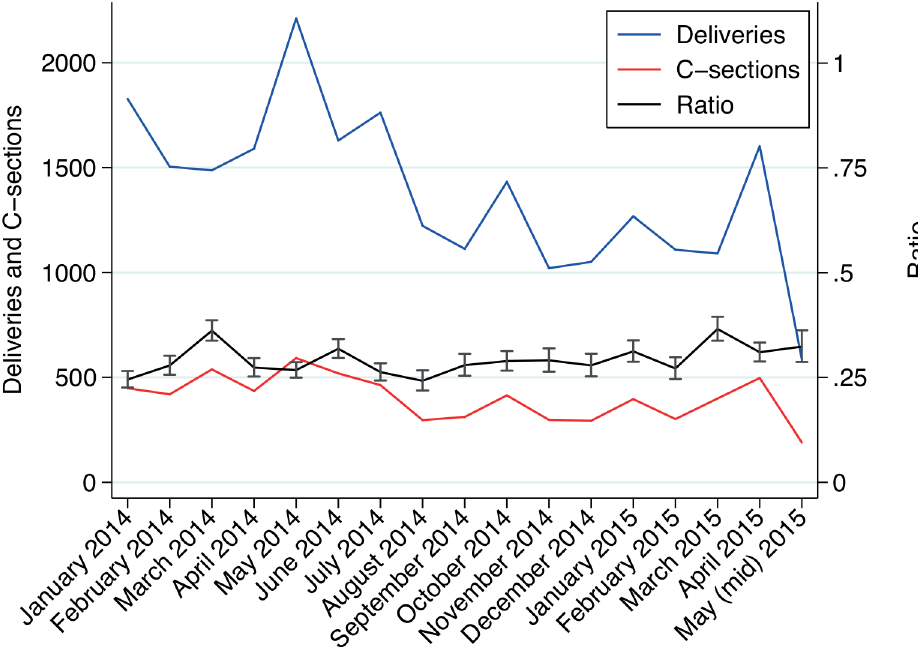
Fig 3. Monthly number of in-hospital deliveries and C-sections nationwide during the study period. Also shown is the ratio of C-sections of all in-hospital deliveries with a 95% CI.